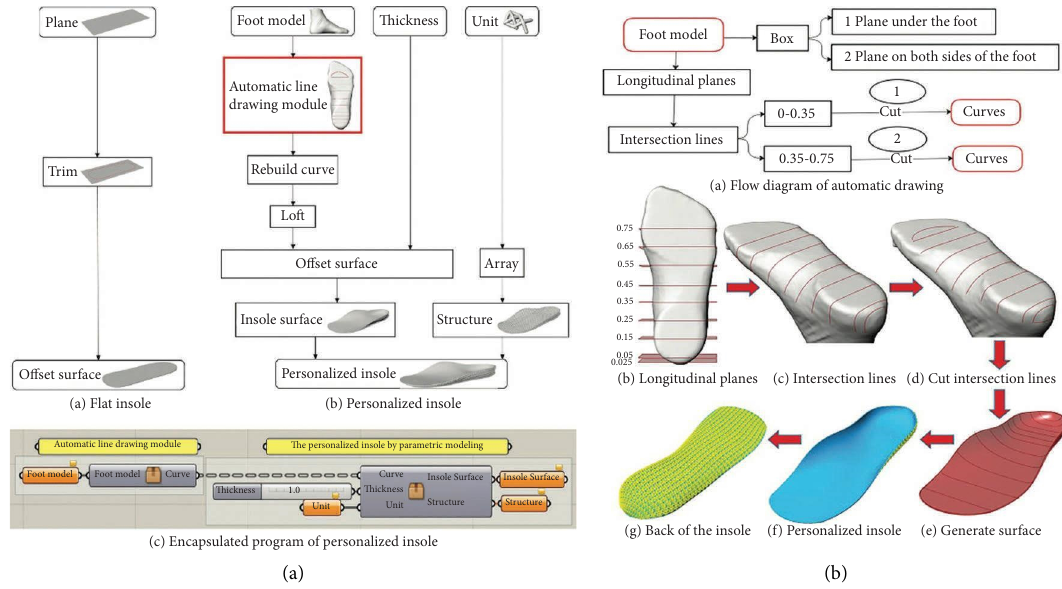
Figure 23: (a) Parametric modeling implementation. (b) Sketch of automatic drawing module.